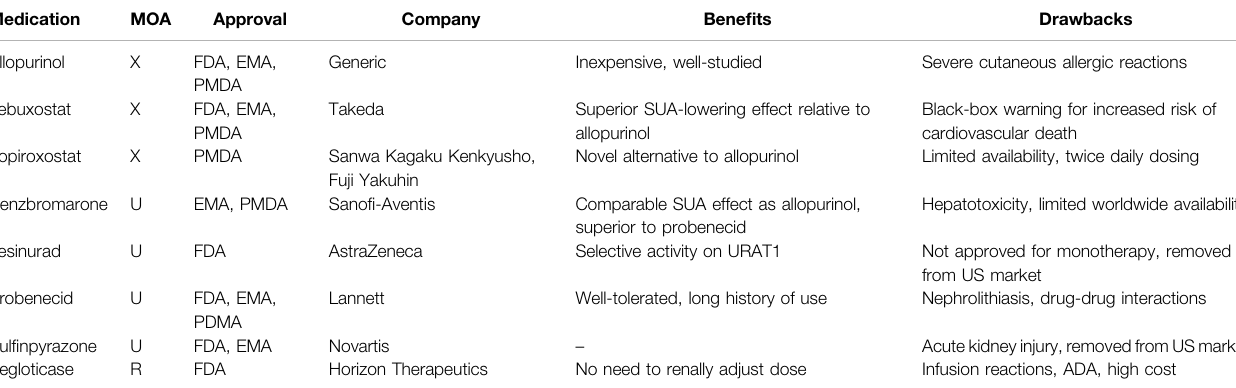
TABLE 1 | Urate-lowering therapeutic drugs approved in any